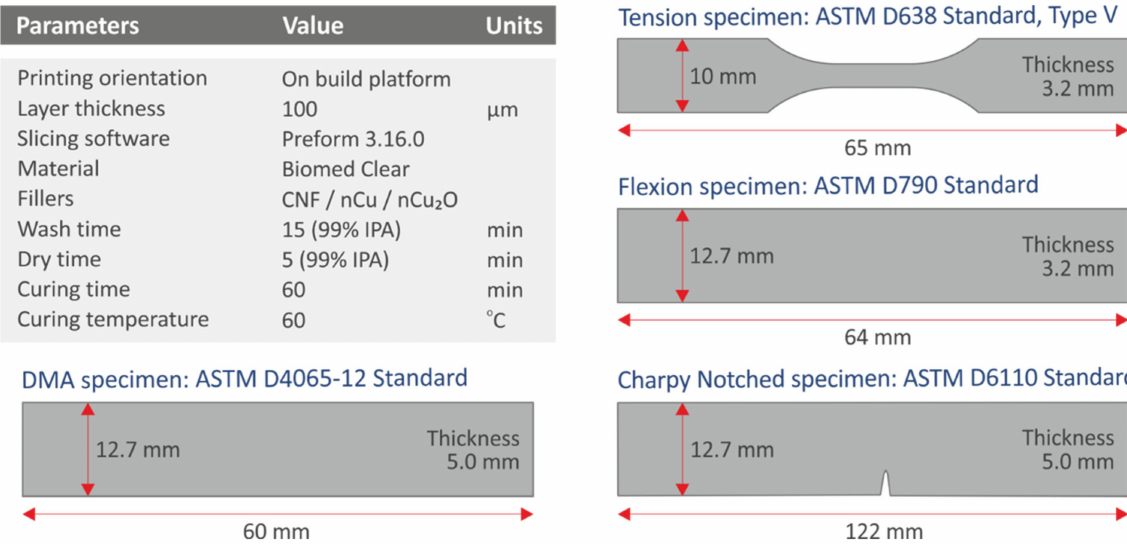
Figure 2. 3D-printing and post-processing parameters of the vat photopolymerization AM method followed in this study. The different specimens’ geometry and dimensions are also depicted. For each mechanical test, samples were fabricated according to the requirements of the corresponding American Society for Testing and Materials (ASTM) international